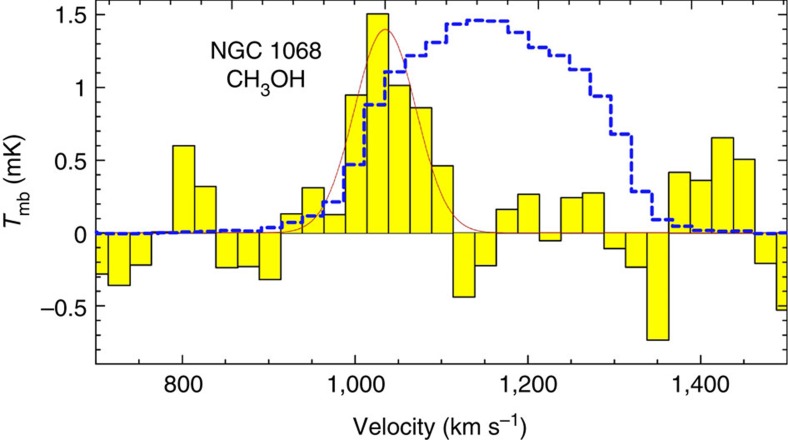
CH3OH maser emission detected in NGC 1068.CH3OH 5−1-40E spectrum in NGC 1068 (black line and filled yellow histogram), smoothed to a velocity resolution of 24.9 km s−1, which gave the noise level of 0.37 mK. The x axis is the radio-defined velocity of CH3OH 5−1-40E, while the y axis is the main beam brightness temperature. The blue dashed line represents the simultaneously obtained HCN 1-0 spectrum, which has been scaled down by a factor of 50, while the red line is the Gaussian fitting of the CH3OH 5−1-40E spectrum.